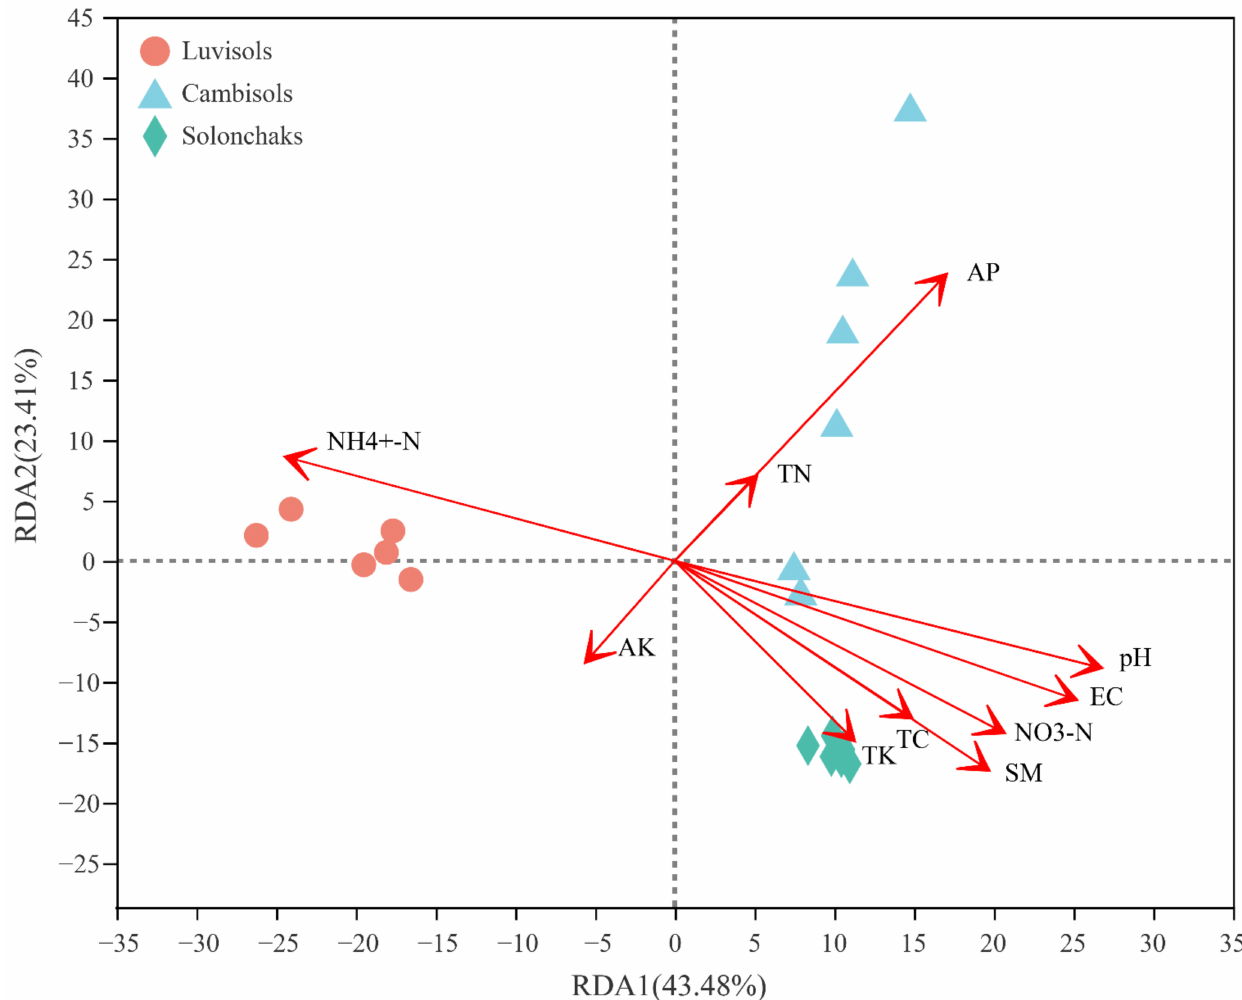
Figure 5. RDA analysis of rhizosphere soil factors and bacteria in pecan